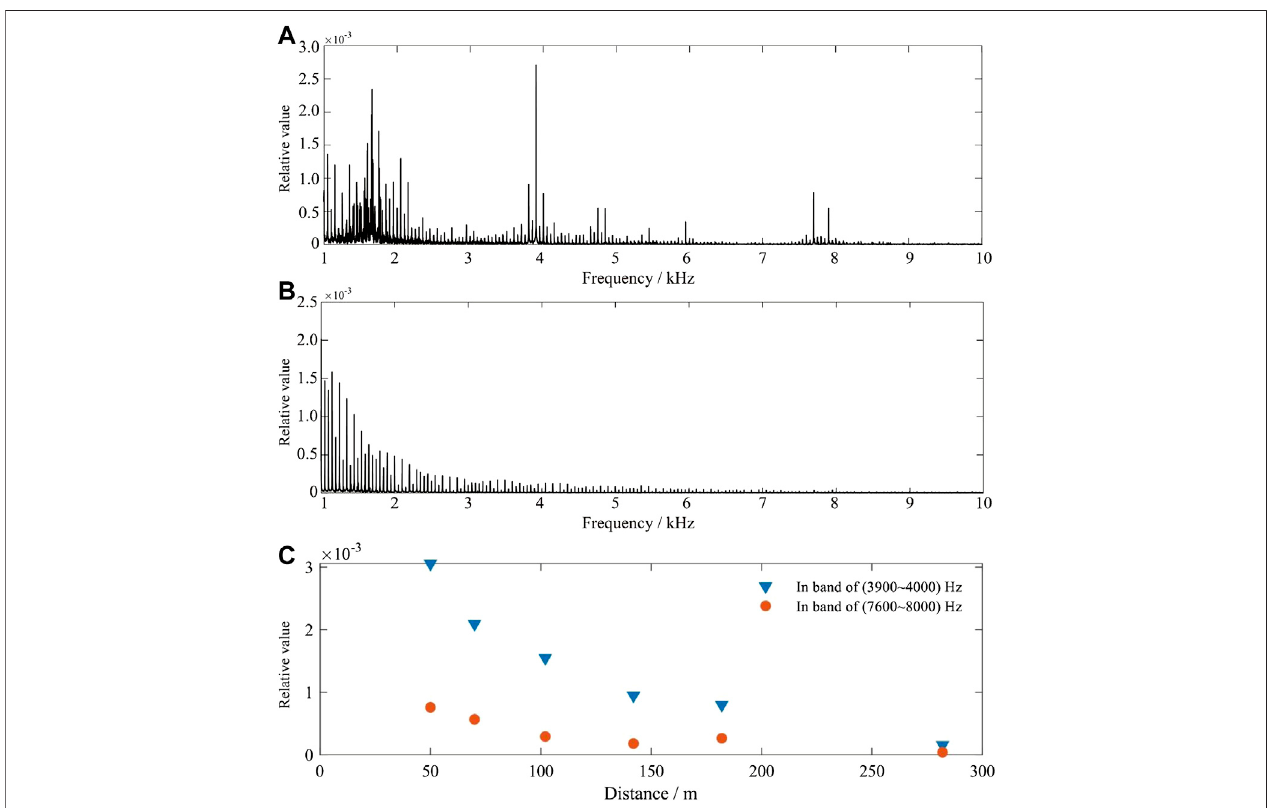
FIGURE5| Measurementresultsofthemagnetic fi eldneartheShunyiAC-to-ACsubstation.Normalizedvaluesofthemagnetic fi elddensityat50 m (A) and280 m (B) away from the substation. Panel (C) show variations of the maximum magnetic fi eld density in bands of 3,900 – 4,000 Hz and 7,600 – 8,000 Hz with distance away from the